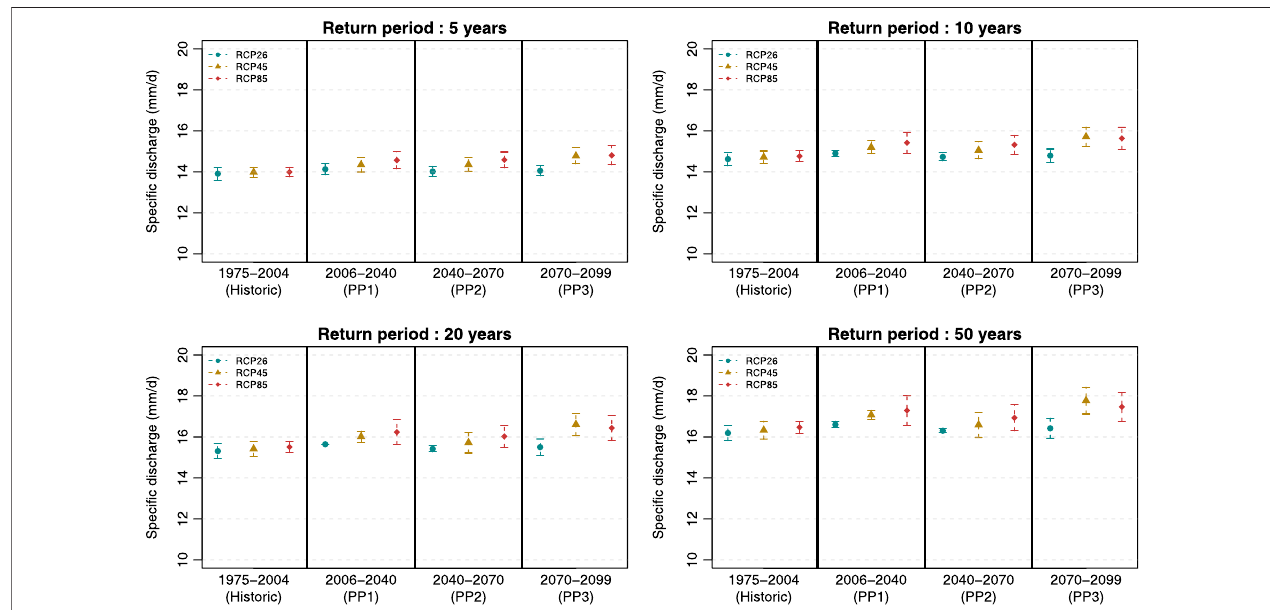
FIGURE7| EvolutionoftheQRP05,QRP10,QRP20andQRP50valuesunderprojectedclimate.Forallsituations,i.e.thehistoricalperiodandthethreefuturesub- periods under the three RCPs, each QRP was calculated from the corresponding fi tted piecewise function (see Eq. 8 ) from the available CPs according to the RCPs ( Table 1 ), and supported by a con fi dence interval at 95% (bars in the graphics).